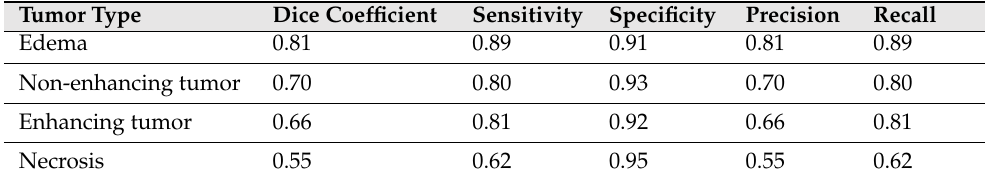
Table 13. Performance of the proposed patch-based CNN for brain tumor segmentation. Tumor